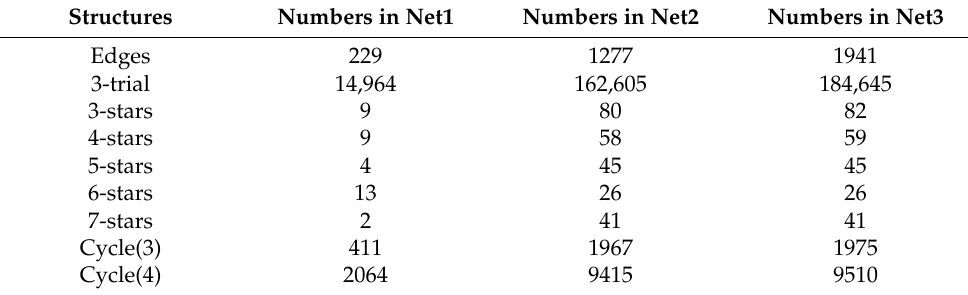
Table 5. Numbers of network structures.